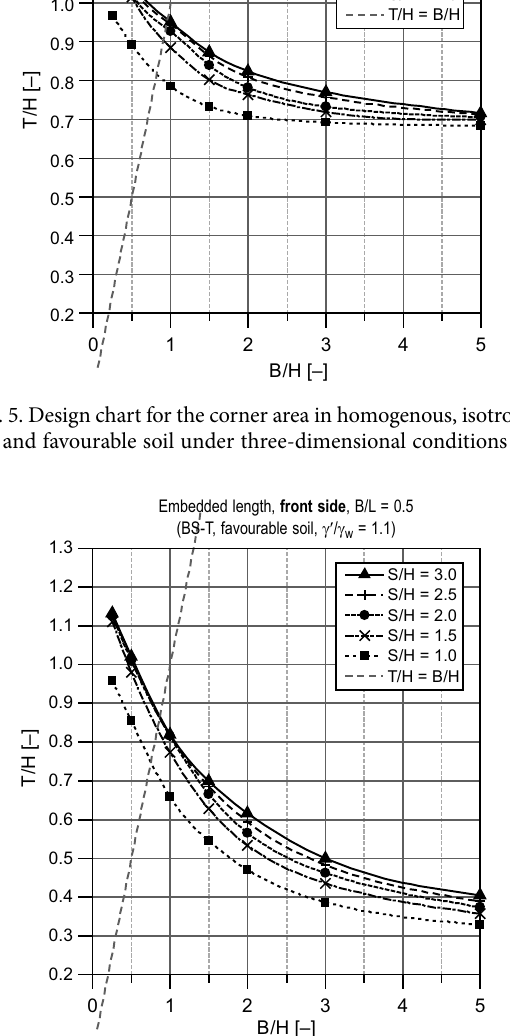
Fig. 7. Design chart for the long side in homogenous, isotropic and favourable soil under three-dimensional